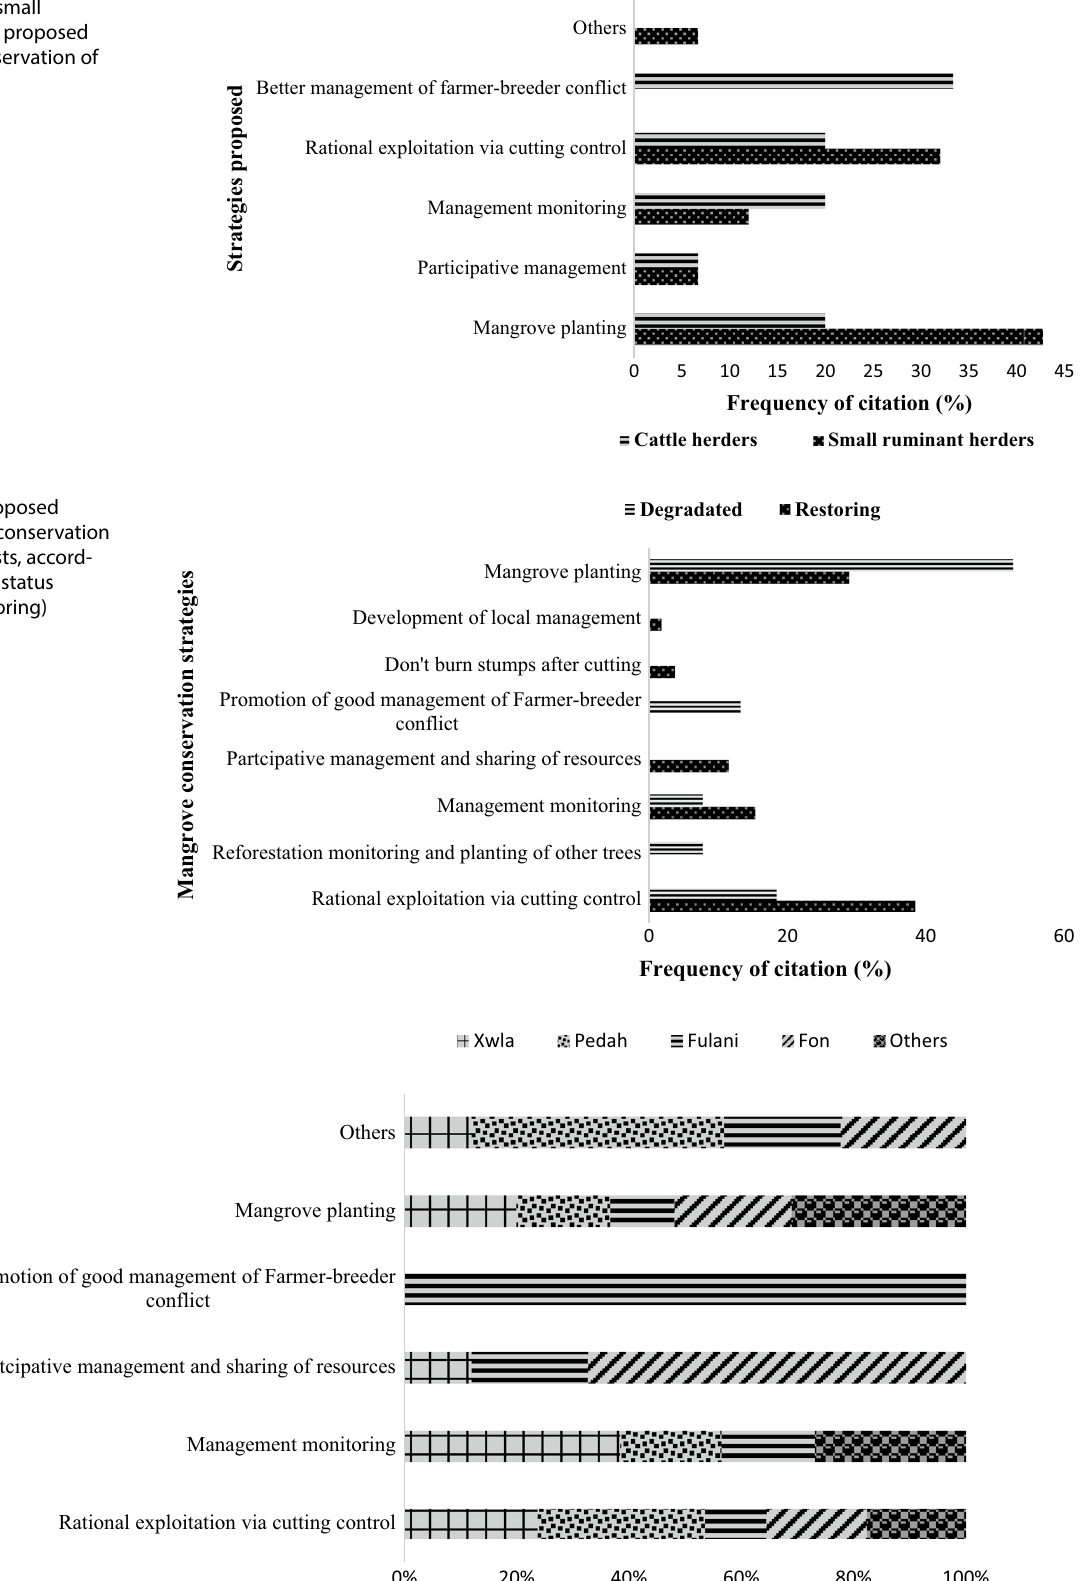
Fig. 6 Herders proposed strategies for mangroves conservation according to their ethnical